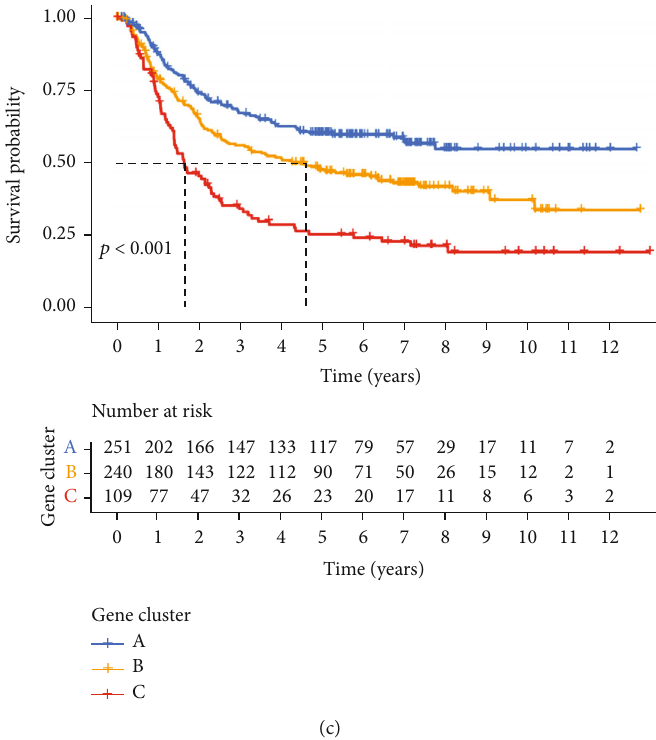
Figure 1: Gene cluster analysis. (a) Venn plot of the 45 intersecting prognosis-related genes. (b) Heatmap of gene clusters. (c) Kaplan – Meier survival analysis regarding gene clusters and OS in the training